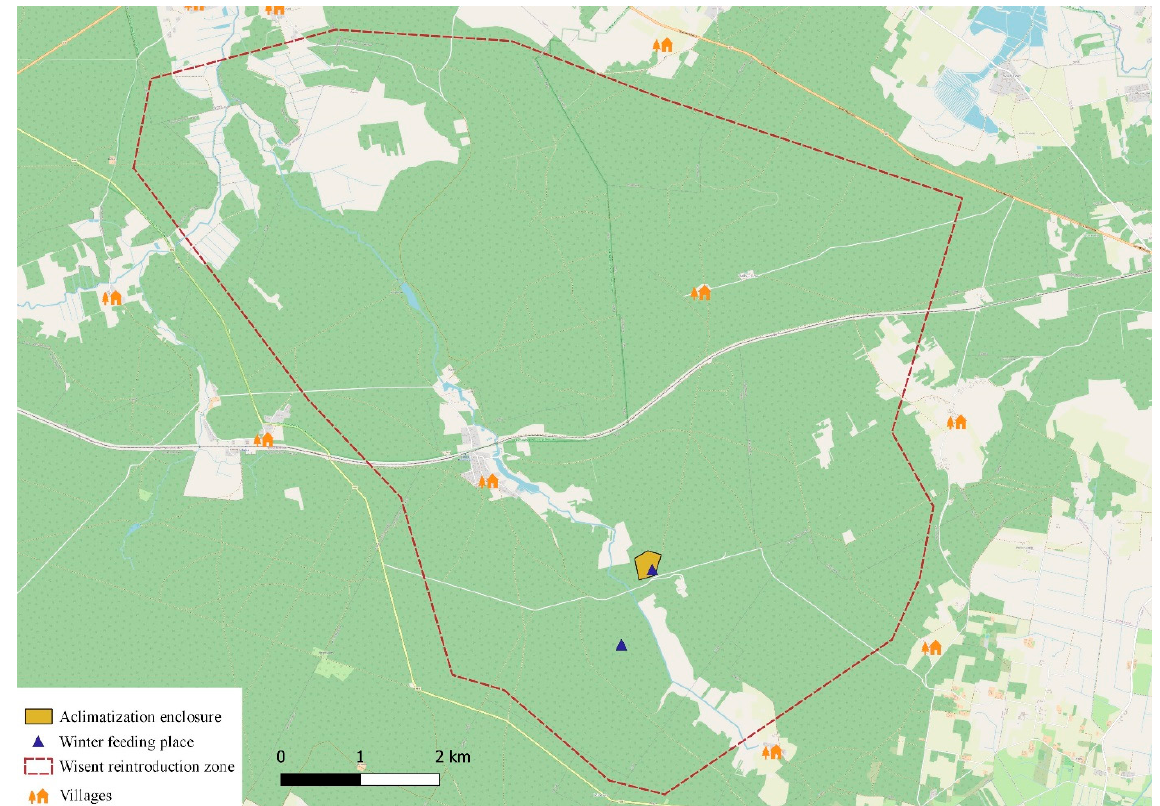
Figure 1. The area of reintroduction of European bison in the Ż ednia Forest District in Knyszynska Forest .